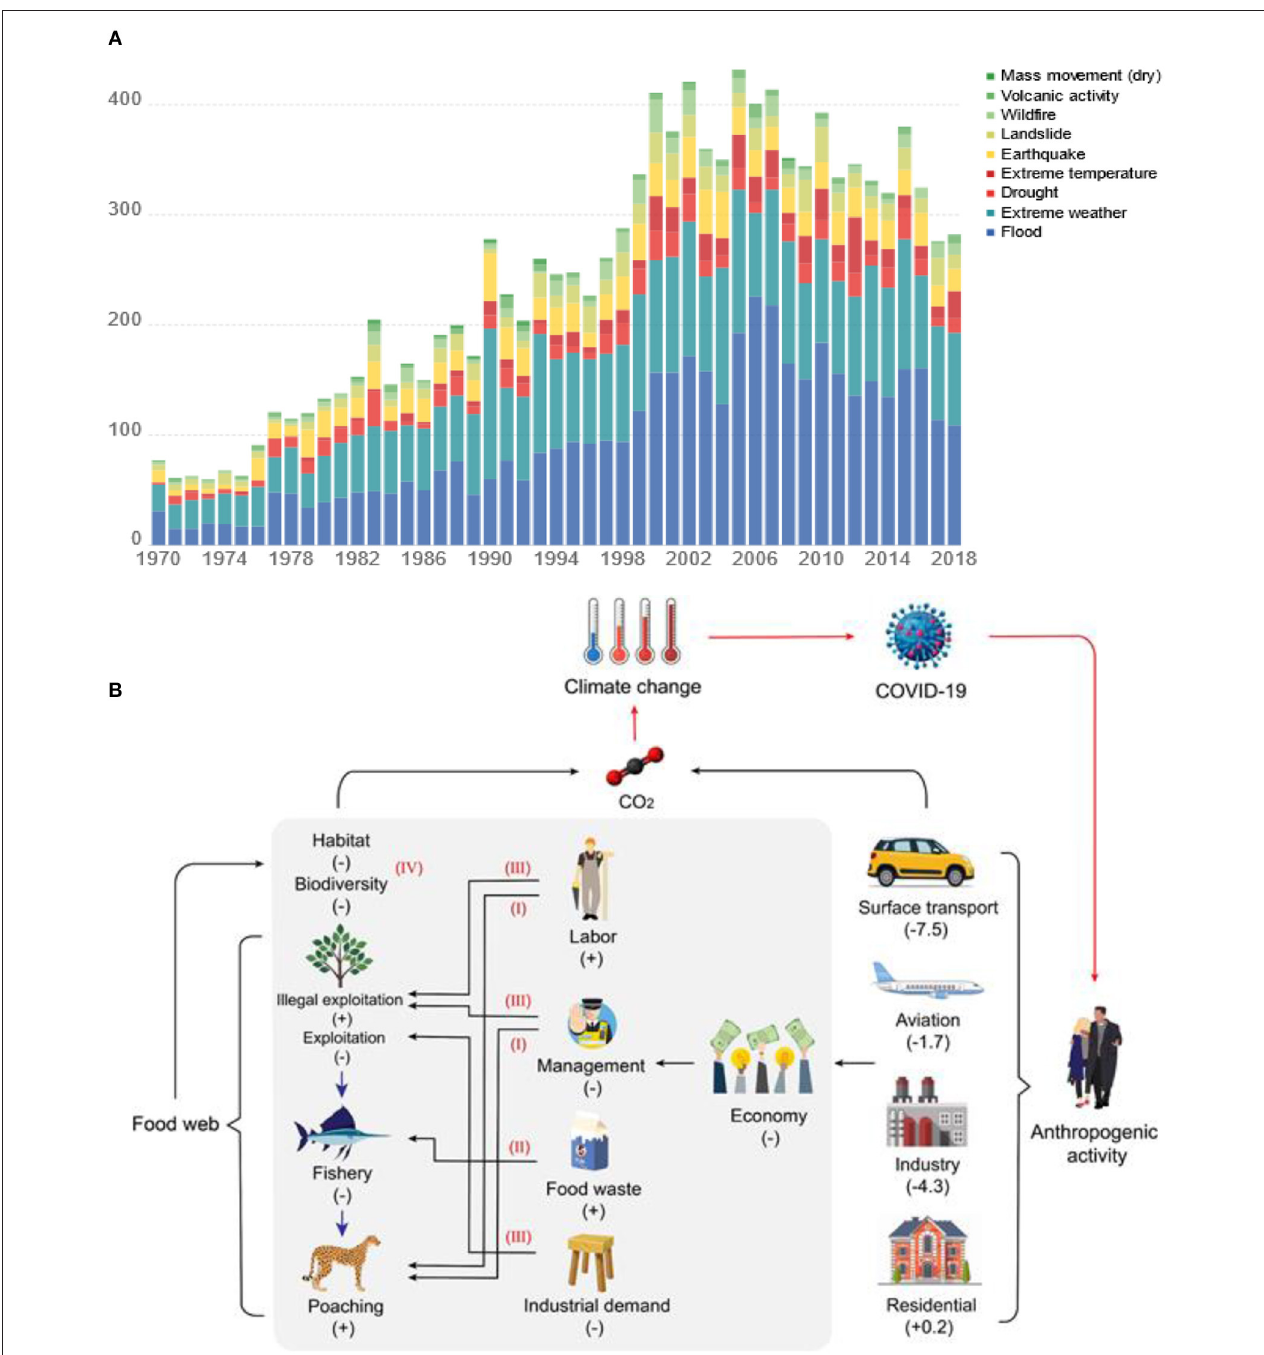
FIGURE 6 | Global reported natural disasters by type for 1970–2019 (https://ourworldindata.org/natural-disasters) (A) and the impact of the COVID-19 pandemic on carbon emissions (B) . Proposed omissions in carbon emissions related to the food web are described within the area of gray shading. The red roman numerals I-IV correspond to estimation omissions described in the text. The red arrows outside the gray shaded area represent feedbacks and interactions within the virus-climate change-anthropogenic activity-carbon cycle continuum. “ + ” indicates that the component is promoted and “-” indicates that the component is weakened. The values in brackets are range in daily fossil CO 2 emission on 7 April 2020 compared to mean daily 2019 levels 5 , unit: MtCO 2 day − 1 .